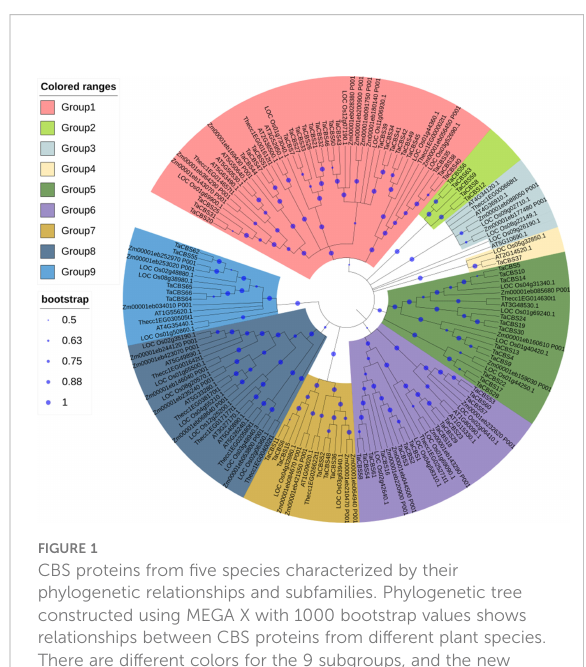
FIGURE 1 CBS proteins from fi ve species characterized by their phylogenetic relationships and subfamilies. Phylogenetic tree constructed using MEGA X with 1000 bootstrap values shows relationships between CBS proteins from different plant species. There are different colors for the 9 subgroups, and the new names and accession numbers in wheat are listed in Table 1.